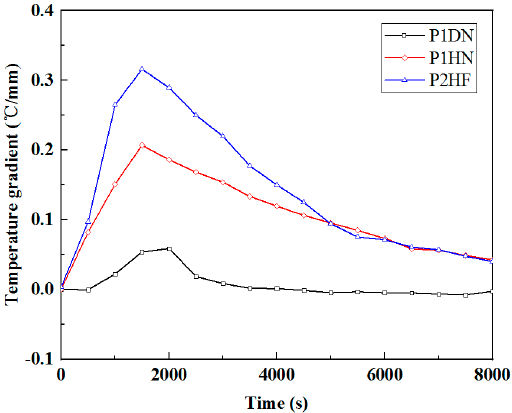
Figure 11. Temperature gradient between the top (SP1) and bottom (SP3) of the sand mold.